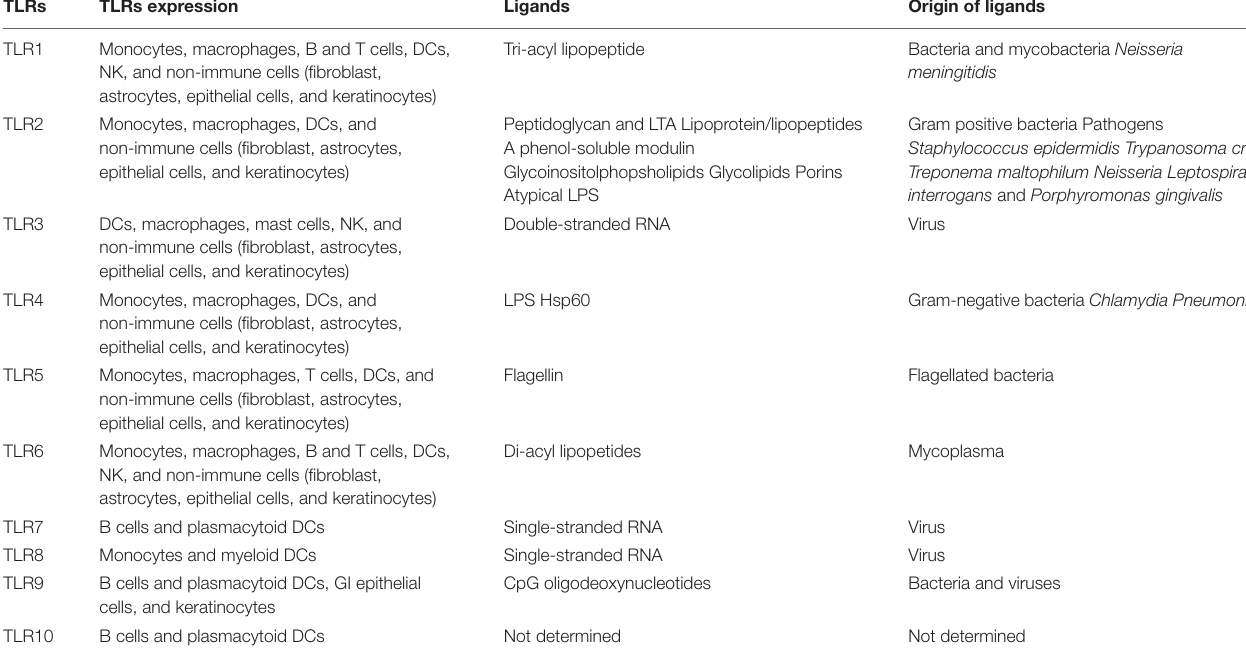
TABLE 1 | TLR expression on immune/non-immune cells and their